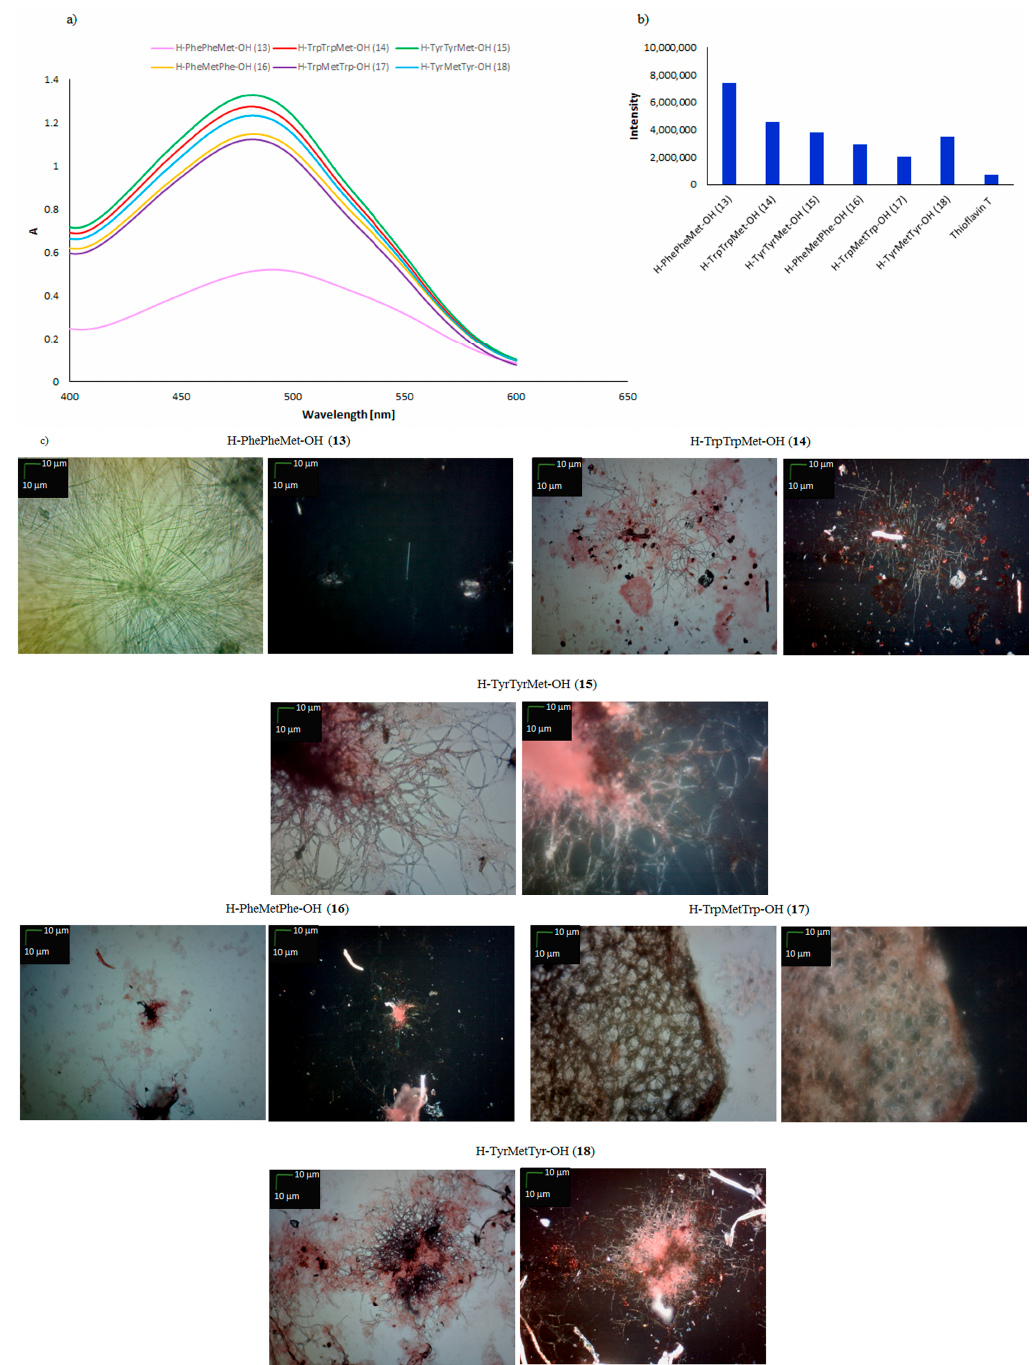
Figure 5. ( a ) UV-Vis spectra of CR in the presence of H–PhePheMet–OH ( 13 ), H–TrpTrpMet–OH (14), H–TyrTyrMet–OH ( 15 ), H–PheMetPhe–OH ( 16 ), H–TrpMetTrp–OH ( 17 ), and H–TyrMetTyr–OH ( 18 ). Spectra were obtained on the fourth day of incubation; ( b ) fluorescence intensity of ThT in the presence of peptides 13 – 18 . Spectra were obtained on the fourth day of incubation; ( c ) pictures of peptides 13 – 18 , taken without a polarized filter (left side) and with a polarized filter (right side) (10×) (Scale bars, 10 μ m). Samples for microscopic examination were taken on the fourth day of incubation. Microscopic examination both with and without a polarizing filter indicated the formation of fibrous structures by H–PhePheMet–OH ( 13 ) (Figure 5c). For the other peptides in this group ( 14 – 18 ),